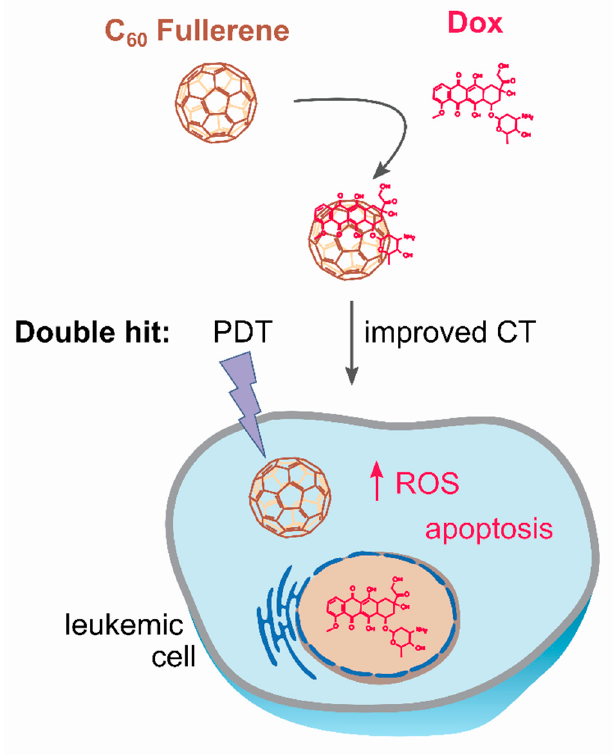
Figure 1. C 60 -Dox nanocomplex for photodynamic chemotherapy: C 60 delivers Doxorubicin (Dox) into leukemic cells and intensifies its accumulation; following internalization, the drug is anticipated to be released from the nanocomplex; cancer cell is exposed to the double cytotoxic hit from both photoexcited C 60 (photodynamic therapy, PDT) and co-delivered Dox (improved chemotherapy, CT).